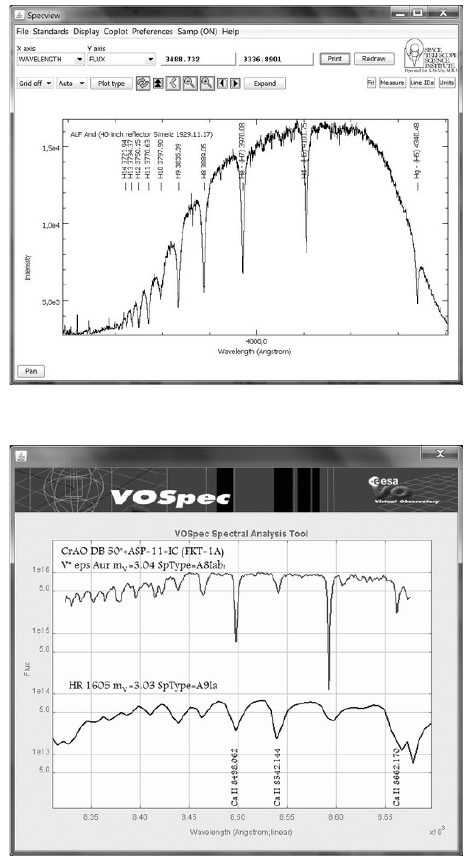
Fig. 4. Examples of the presentation of spectroscopic observations from the CrAO DBO collection with IVO